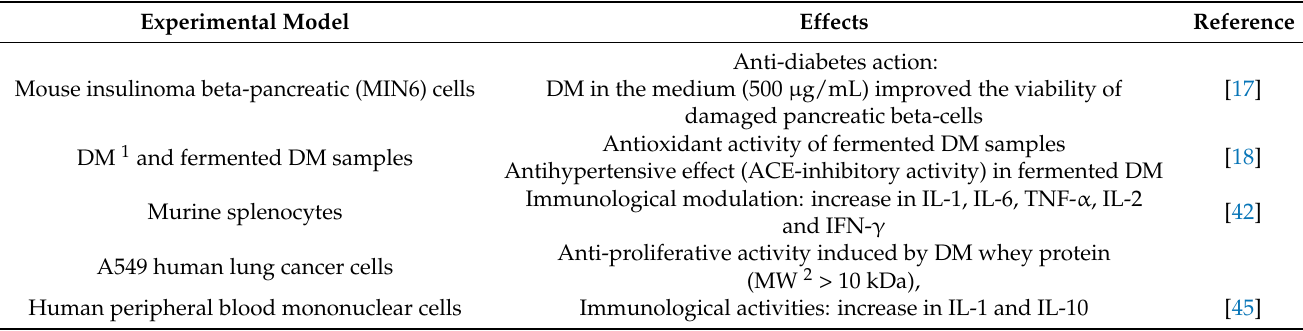
Table 3. In vitro studies on the beneficial effects of donkey milk.